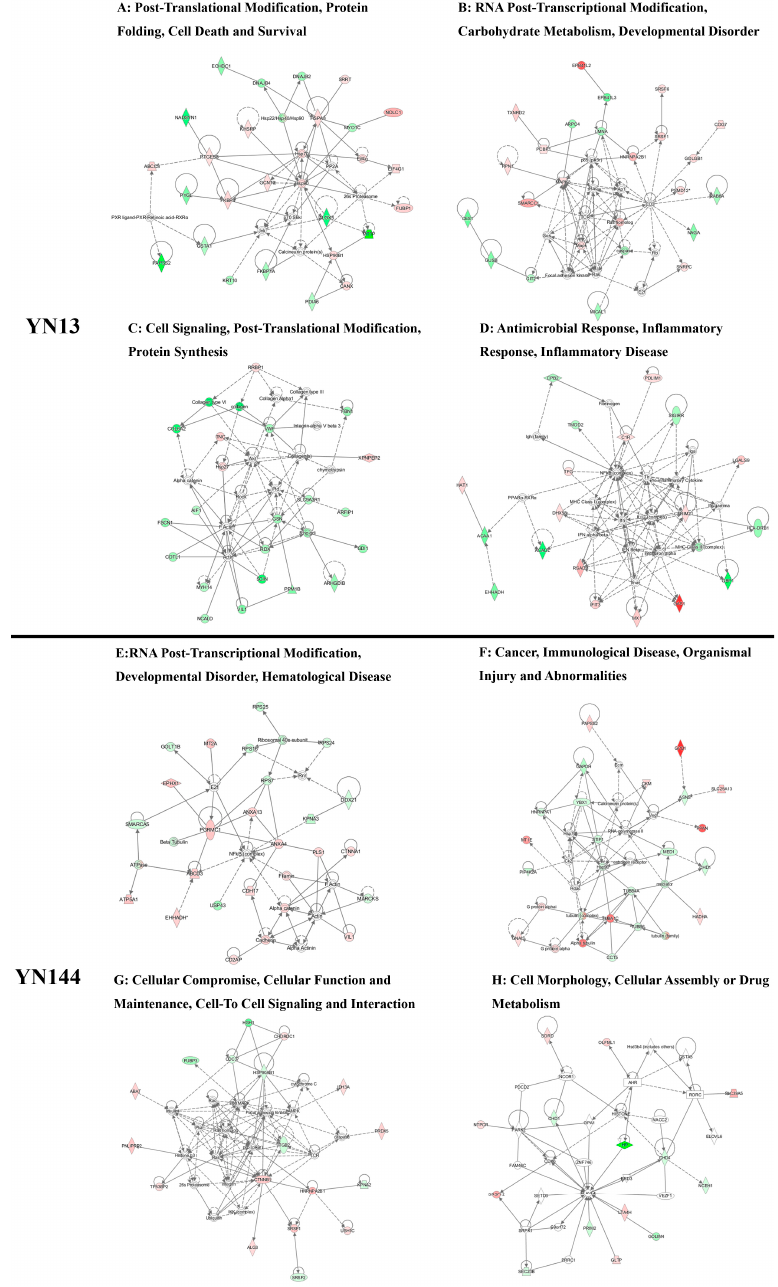
Figure 4. Specific network analysis of significantly differently expressed proteins for YN13 and YN144-infected groups. The red icons represent significantly upregulated proteins; the green icons represent significantly downregulated proteins; and the white icons represent proteins that were not identified in this study but are involved in the networks. The color shade indicates the magnitude of the change in protein expression. The shapes are indicative of the molecular class, and the lines with arrows indicate the molecular relationships (Supplementary Materials Figure